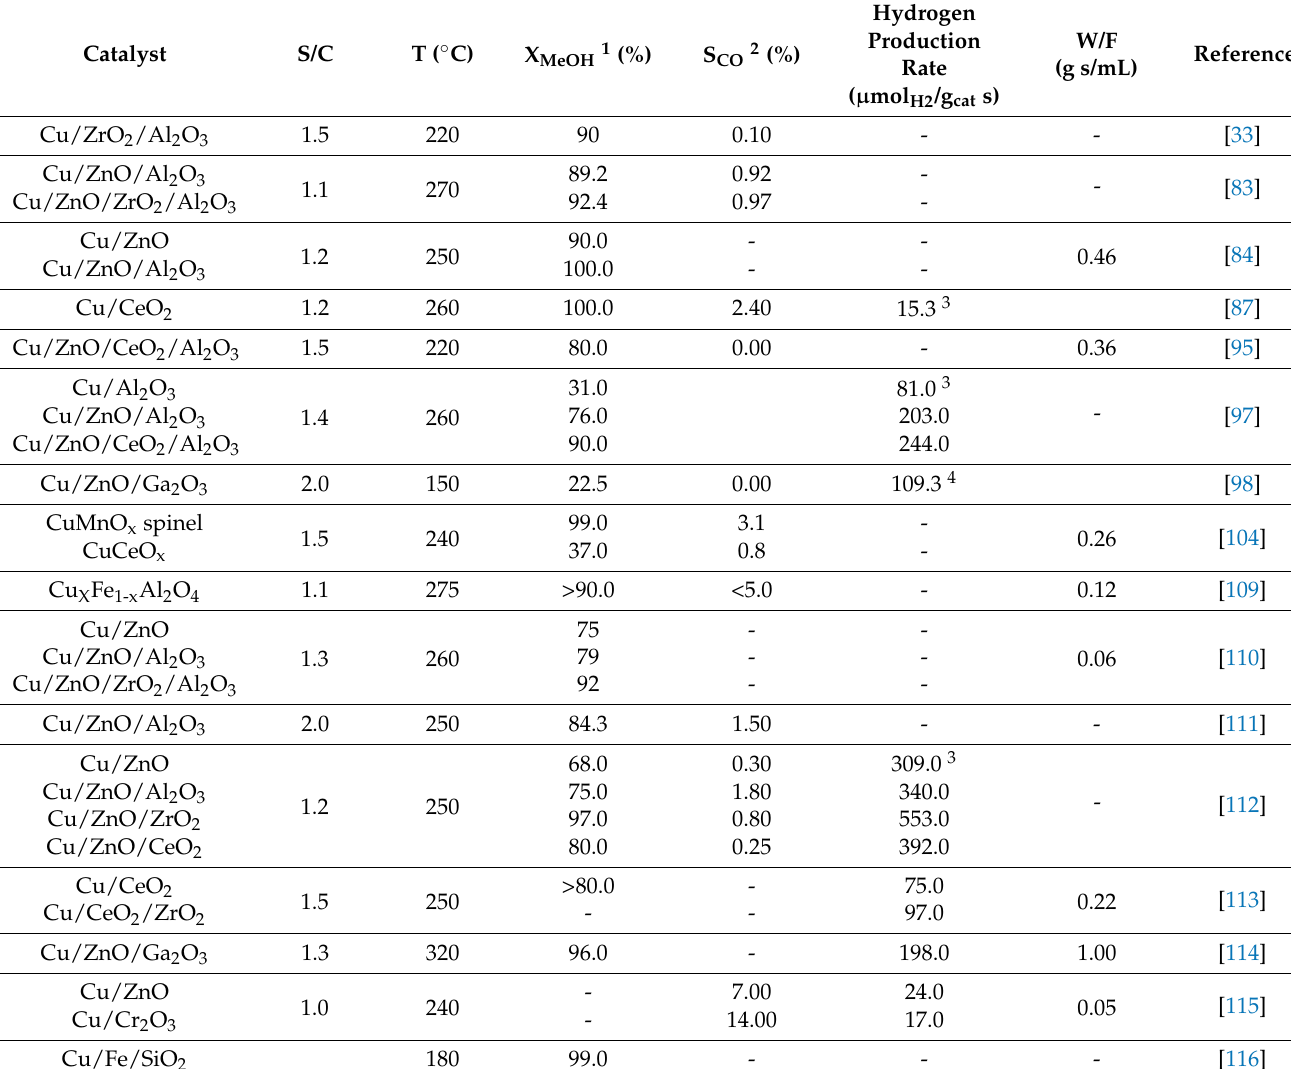
Table 2. Influence of various promoters on the performance of Cu-based catalysts for SRM